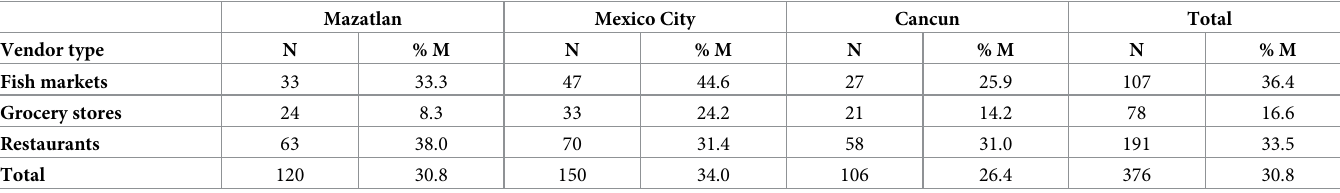
Table 3. Patterns of fish mislabeling found in three cities within Mexico, including sample size (N) and mislabeling rates (% M). Mazatlan Mexico City Cancun Total Vendor